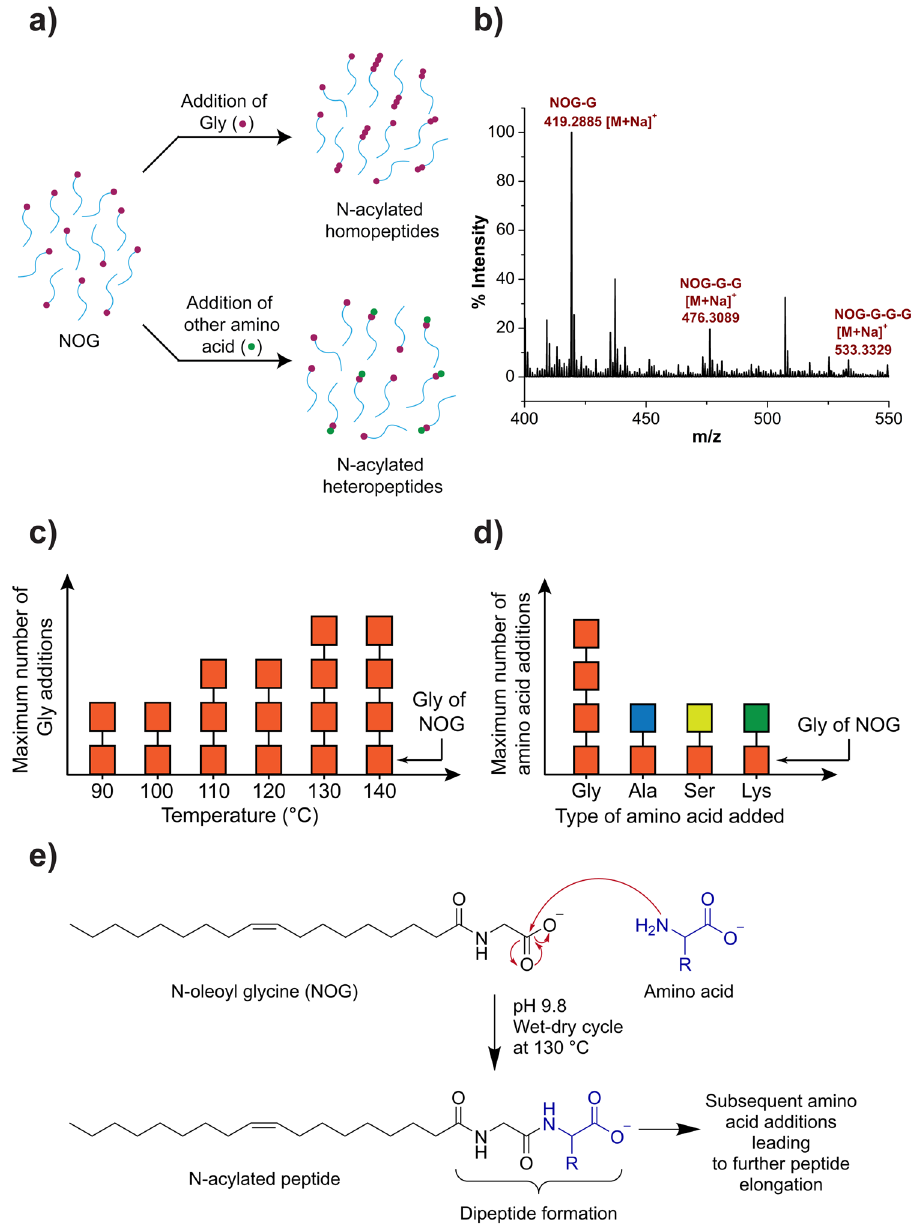
Fig. 4 The addition of amino acids to the NOG head group under wet-dry cycles results in the synthesis of N -acylated peptides. The starting concentrations of NOG and Gly were 3 mM and 200 mM, respectively. Initial reaction pH was 9.8. Reaction was subjected to a single wet-dry cycle of 24 h at 130 °C. a Schematic overview of the reaction, b HRMS analysis (positive mode) of the fi nal lipid content of the NOG + Gly reaction shows up to three Gly additions to the NOG head group (full spectrum shown in Supplementary Fig. 19), c The maximum number of Gly additions increases with increasing temperature, d Single amino acid addition is observed for the reaction of NOG with alanine, serine, and lysine performed under similar reaction conditions as that of the NOG + Gly reaction (see Supplementary Figs. 19 – 27 for the original HRMS data for c and d ), e A plausible mechanism of the reaction, where the acid-amine coupling between NOG and amino acid results in the formation of N -acylated